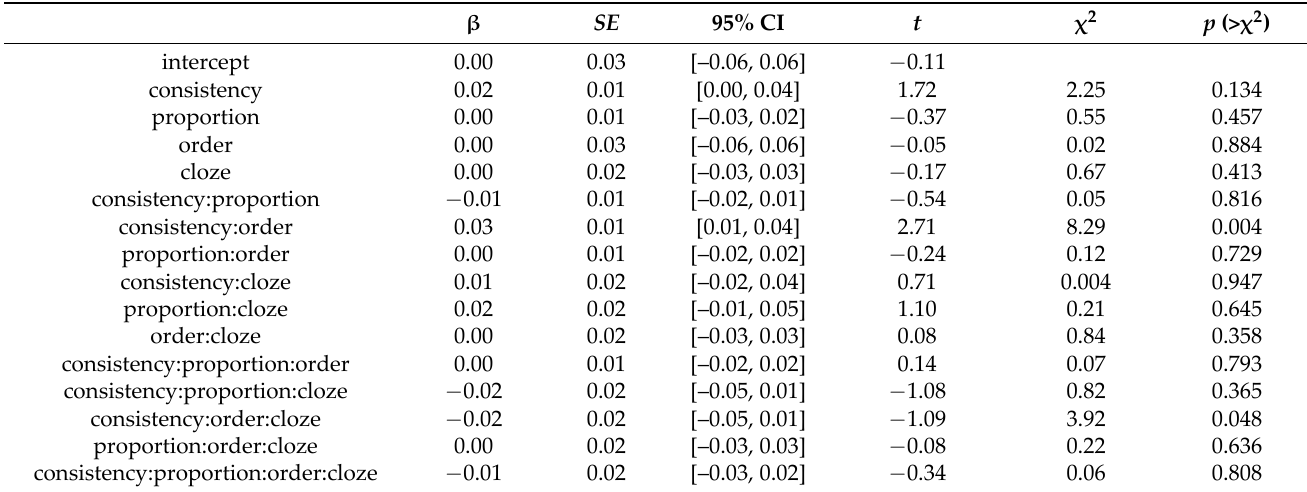
Table 3. Estimates of fixed effects and analysis of deviance (Type II Wald chi‑square tests) for the N400 (300–600 ms) time